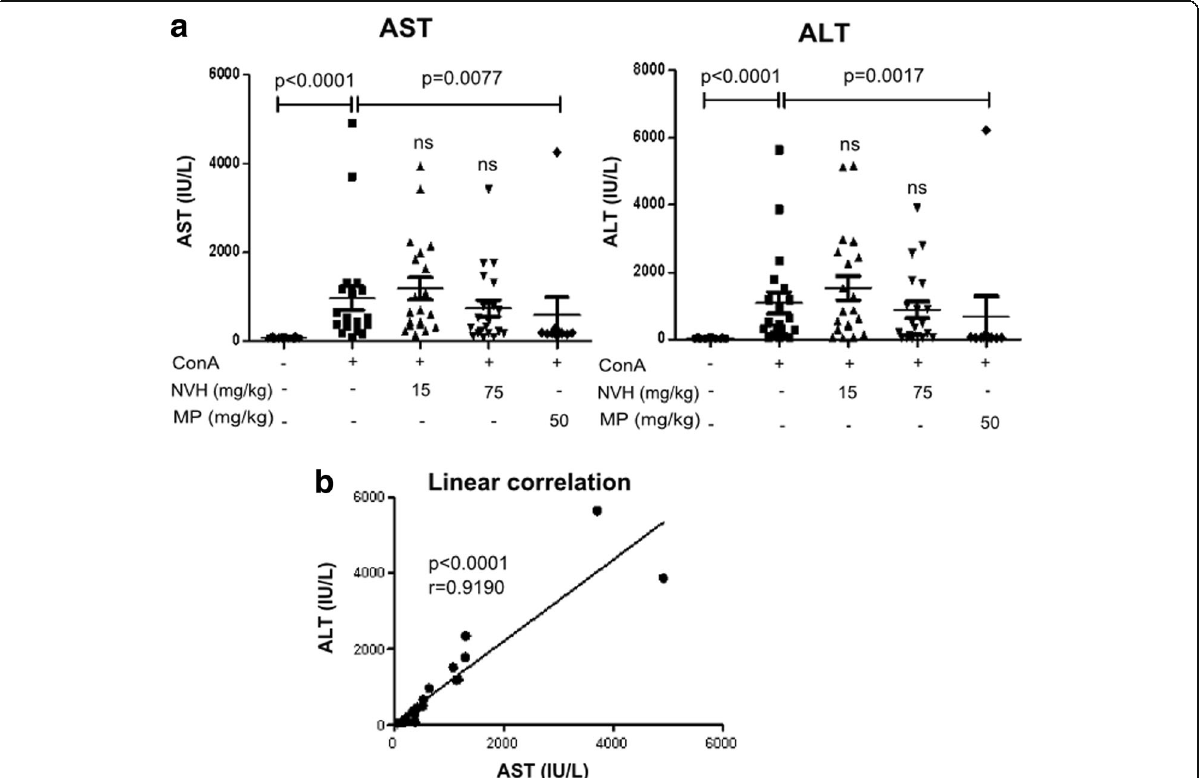
Fig. 10 Transaminases serum level in Concanavalin A-induced liver injury in mice. Animals were pretreated with either NVH extract or methylprednisolone during 3 consecutive days and acute liver injury was immediately induced with Concanavalin A intravenous injection after the last treatment. All animals were sacrificed 8 h after Concanavalin A injection. a : Dot plot showing Aspartate aminotransferase (left panel) and Alanine aminotransferase (right panel) serum level for each mouse in 5 different groups. Medians are indicated by a horizontal line. Significant Dunn ’ s post tests are indicated as * p <0.05; ** p < 0.01; *** p <0.001; ns: non-significant. The p-value indicates the Mann-Whitney test. Two independent experiments were conducted; n ≥ 10 in each group. b : Correlation between Aspartate aminotransferase and Alanine aminotransferase level. AST: Aspartate aminotransferase; ALT: Alanine aminotransferase; NVH: Neoboutonia velutina aqueous extract; MP: Methylprednisolone, ConA: Concanavalin